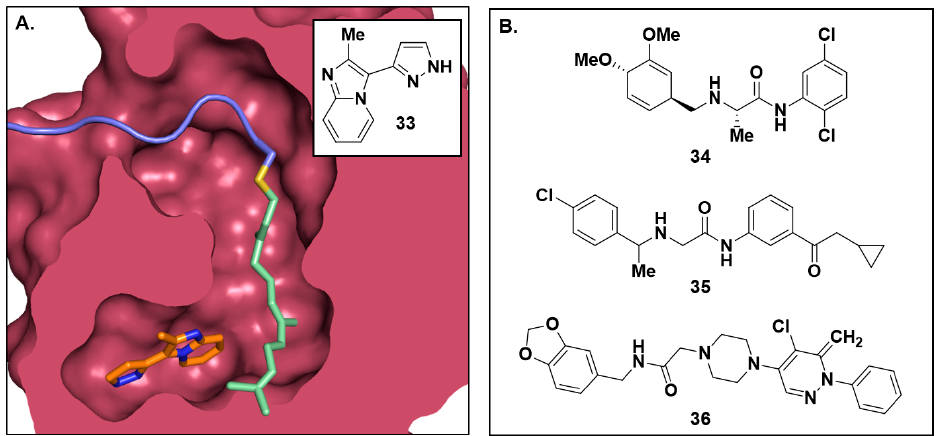
Figure 10. ( A ) X-ray crystal structure of imidazopyridine fragment 33 stabilizing the interaction between PDE δ and a farnesylated C-terminal peptide of KRAS (PDB 7Q9S). PDE δ is shown in red with the KRAS peptide in blue, the farnesyl group in green, and 33 in orange. ( B ) Putative KRAS/PDE δ molecular glues ( 34 – 36 ) identi fi ed via in silico screening techniques.